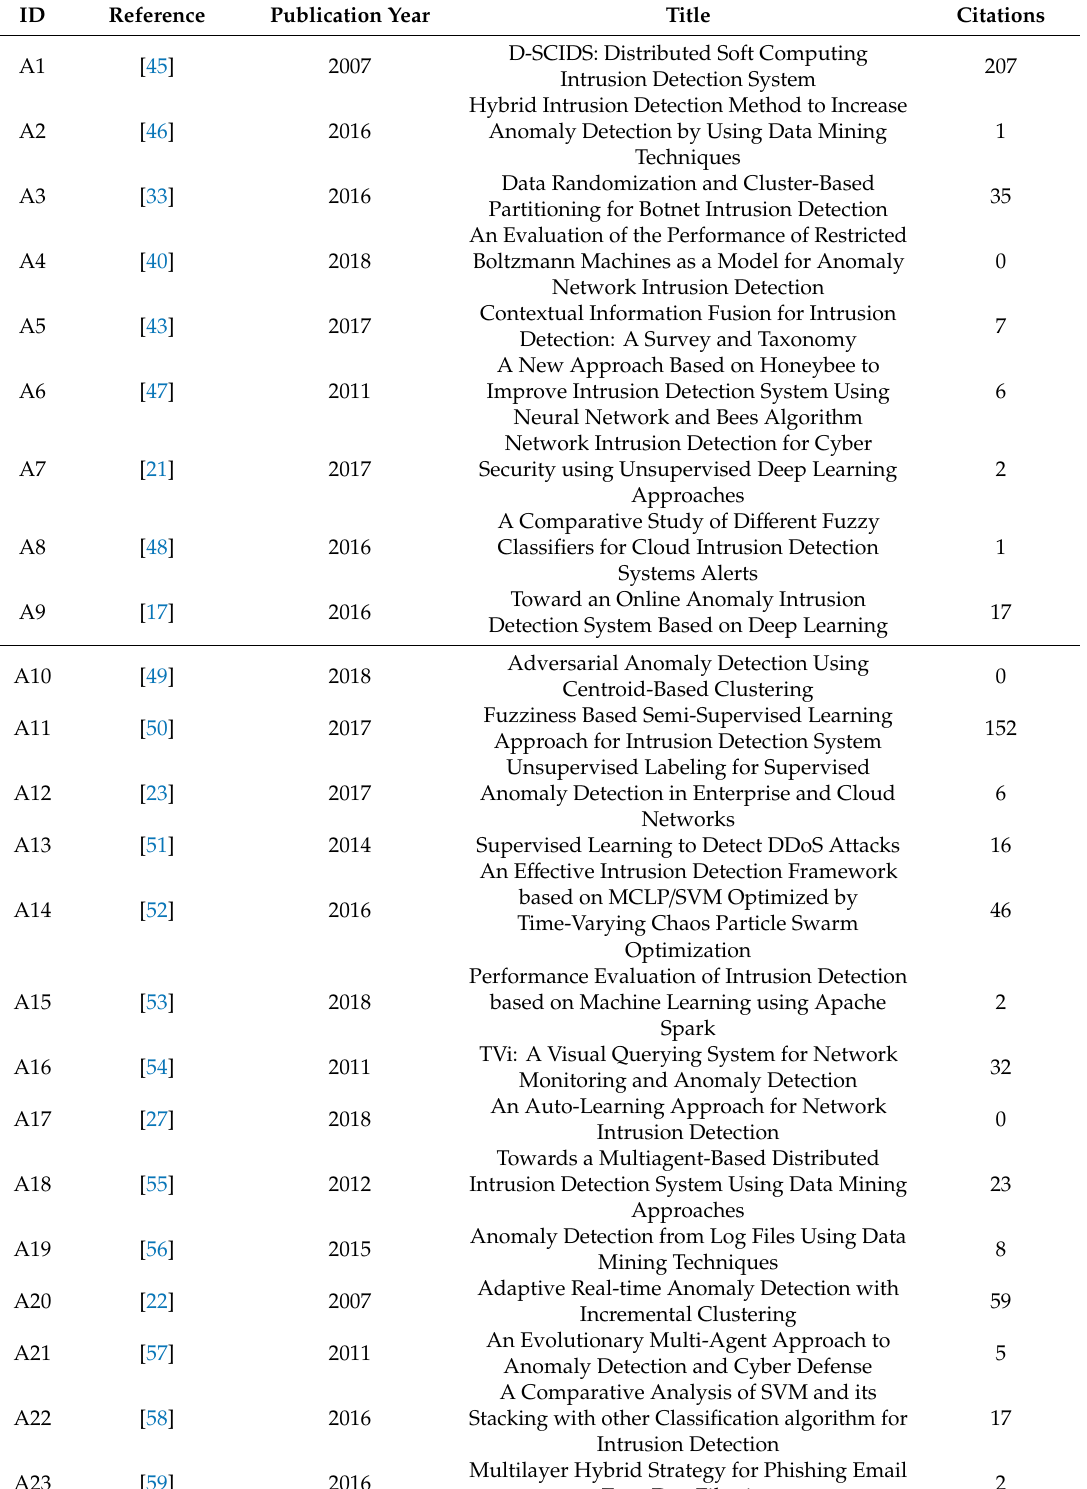
Table A2. Enumeration of reviewed studies (Retrieved 14 February